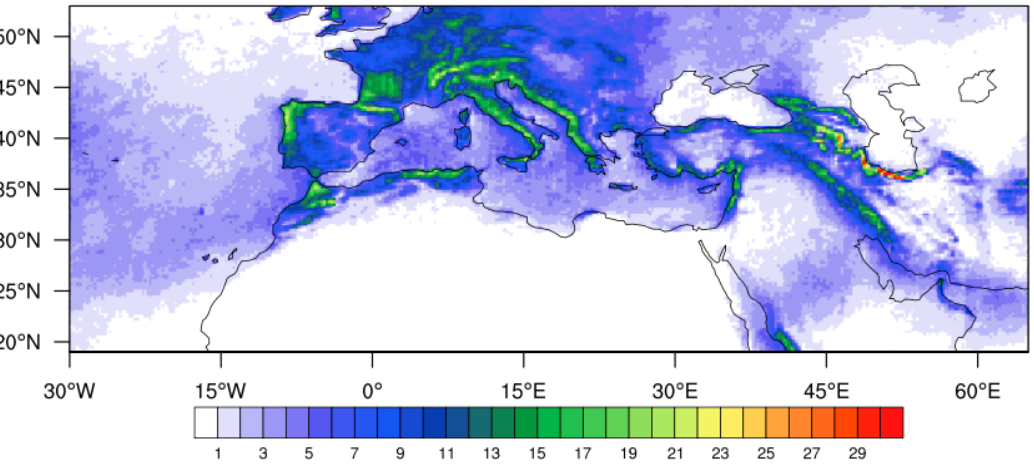
Figure 7. Annual average number of SevER cases calculated with ERA5 data for 1990–2009 .